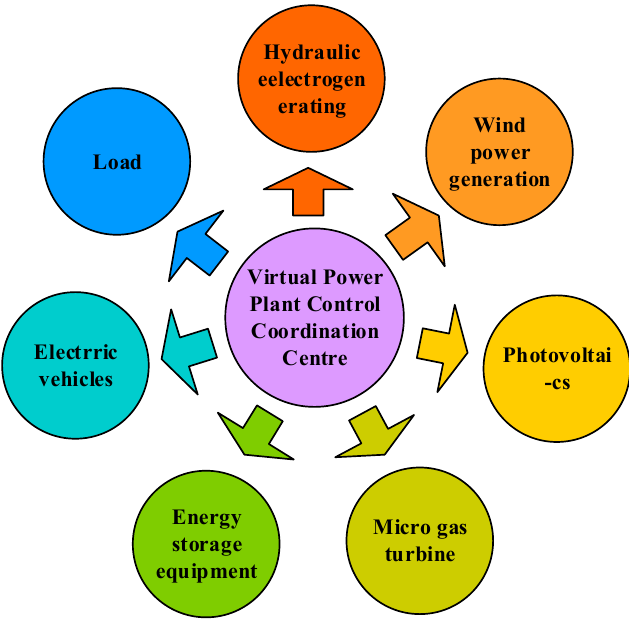
Figure 1. Components of a virtual power plant (VPP).